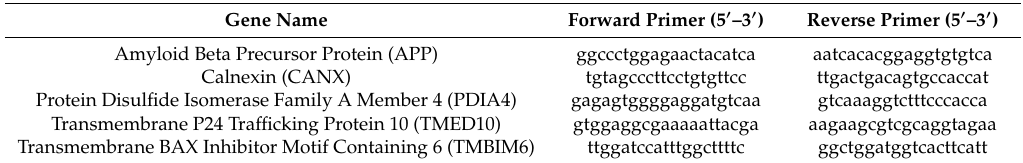
Sequences of primers used for real-time quantitative polymerase chain reaction (RT-qPCR) analysis.